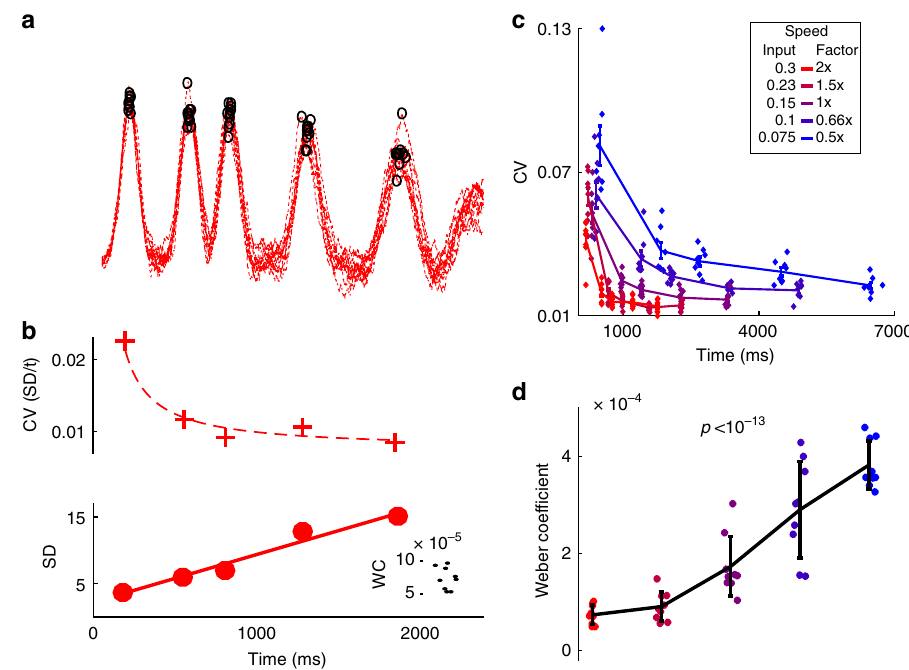
Fig. 4 RNN models of temporal scaling predict a novel Weber-Speed effect. a Ten trials of the output activity of one network at 0.5× speed with tap times indicated by black circles. b Trained RNNs account for generalized Weber ’ s Law, which predicts a linear relationship between the mean and standard deviation of timed intervals. Top: The coef fi cient of variation (CV, SD/ t ) at each of the fi ve taps shown in a . The dotted line shows the CV calculated using the fi t below. Bottom: standard deviation linearly increases with time. Line shows the linear fi t ( r 2 = 0.96). Inset shows the Weber Coef fi cient (the slope of variance vs. mean time) at 0.5× speed for all ten trained networks. c The CV of ten networks calculated from 20 trials at each tested speed. Note that at the same absolute time across speeds, the CV is higher when speed is slower (the Weber-Speed effect). d The Weber Coef fi cient increases at slower speeds (Repeated-measures one-way analysis of variance; F = 54.4, p < 10 − 13 ). Networks ( n = 10) for this analysis were trained and tested at 0.25 noise amplitude. Error bars represent